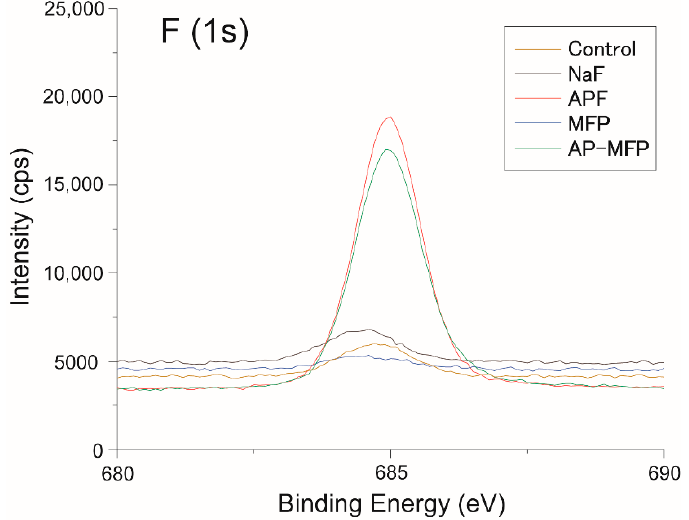
Figure 6. Surface analysis by XPS. The horizontal axis shows the binding energy (eV), and the longitudinal axis indicates the intensity (cps) of fluoride-ion 1S orbit. Yellow, black, red, blue, and green lines show the spectra for the control, NaF, APF, MFP, and AP-MFP groups, respectively. The spectrum of each element obtained was corrected by hydrocarbon-binding energy where C1s = 285.0 eV.